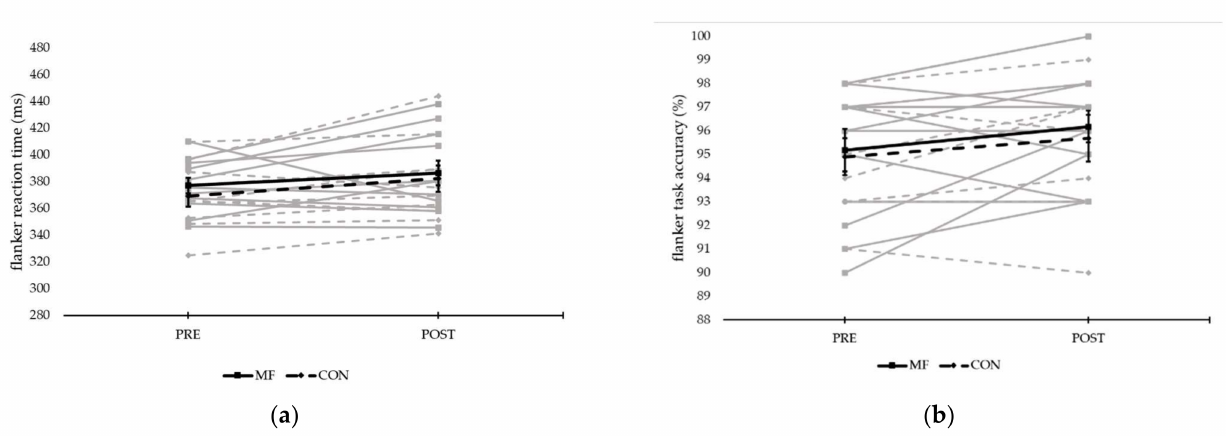
Figure 5. Reaction time and accuracy of the flanker task comparing both conditions pre- and post-experimental/control task in all individuals: ( a ) reaction time (ms); and ( b ) accuracy (%) (grey lines represent individual responses, bold lines represent means ±